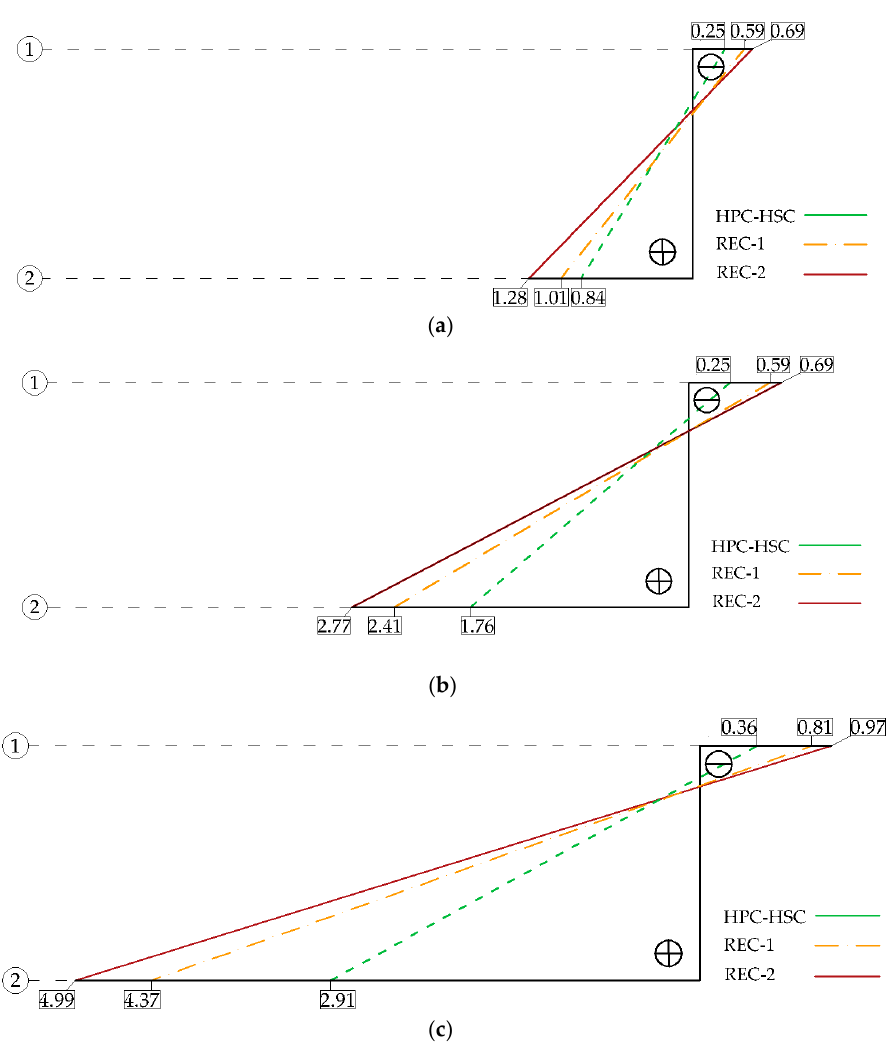
Figure 7. Experimental values of ɛ (‰) concrete deformations along cross-section height for selected forces: ( a ) force 15kN; ( b ) force 25 kN; ( c ) force 35 kN.